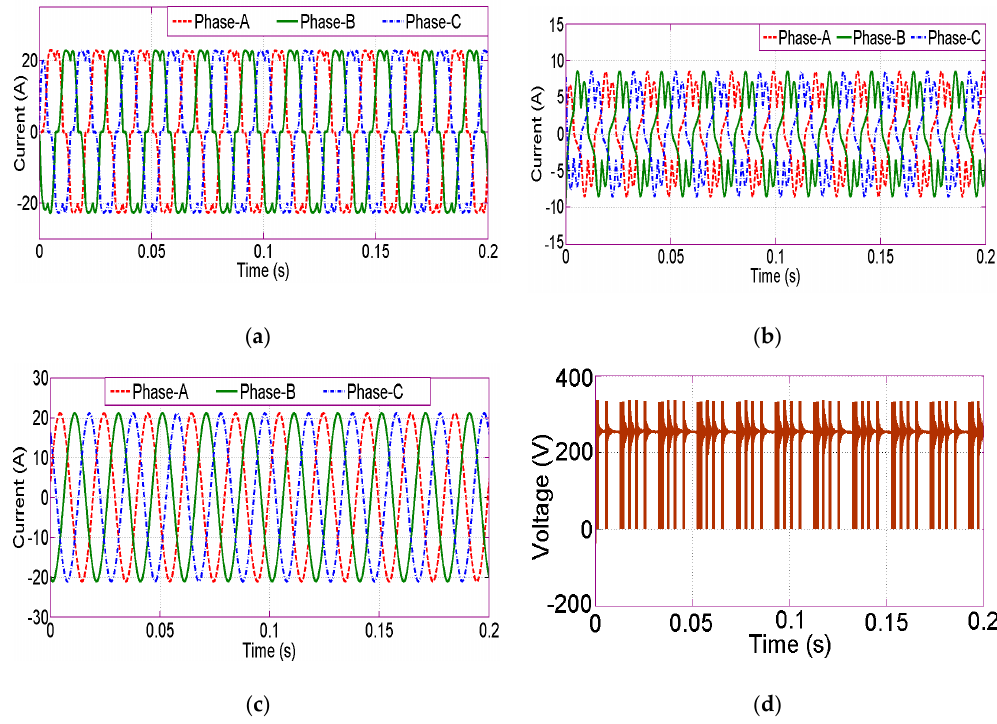
Figure 8. Simulation results under steady state voltage and current: (a) load current; (b) injected compensation current; (c) source current; and (d) DC link voltage.